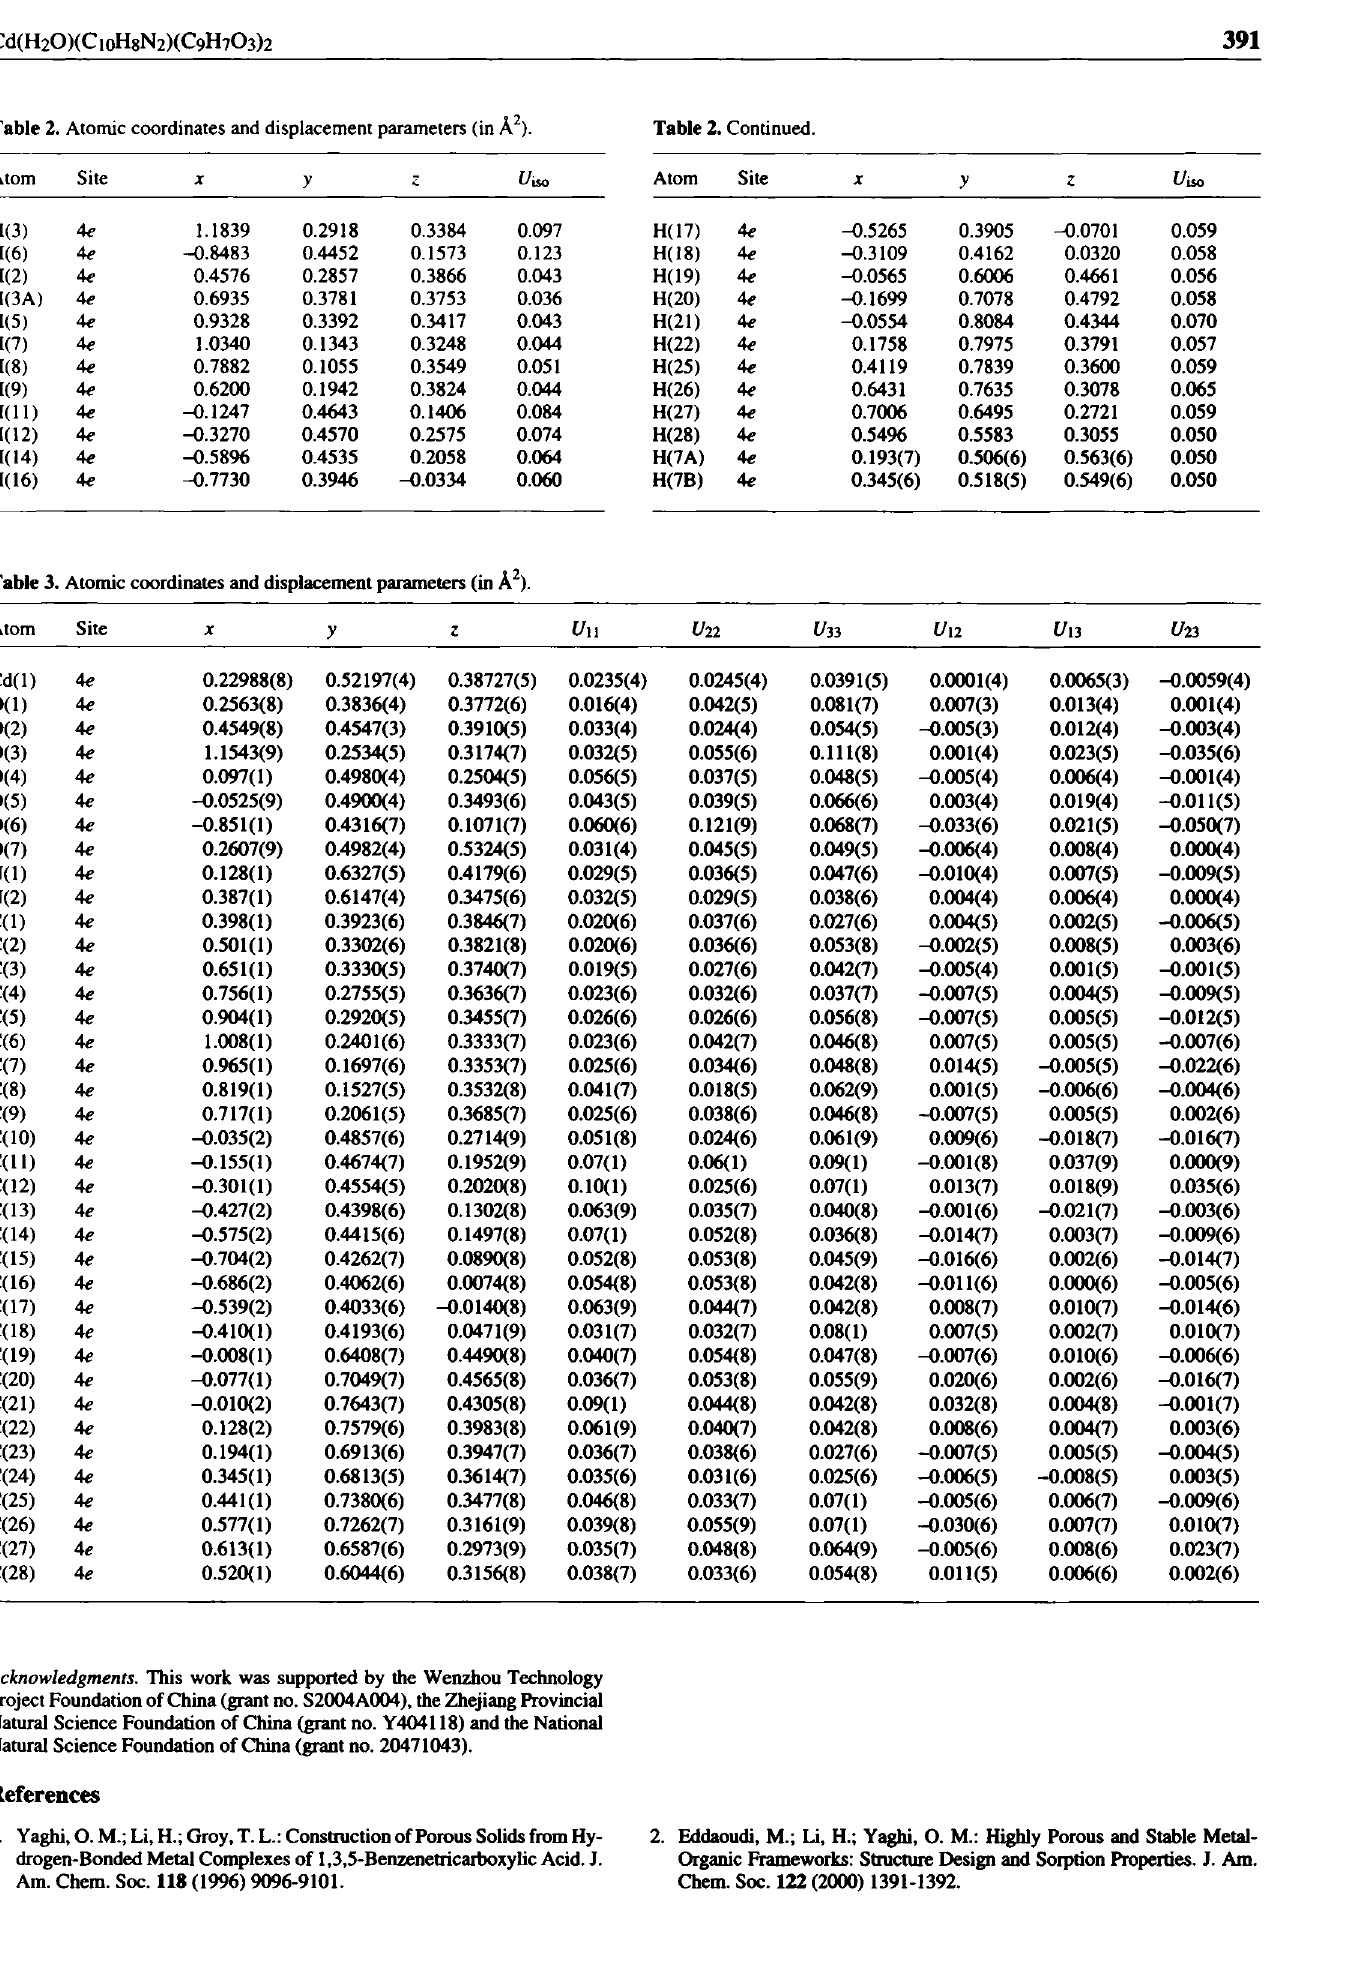
Table 2. Atomic coordinates and displacement parameters (in A 2 ).